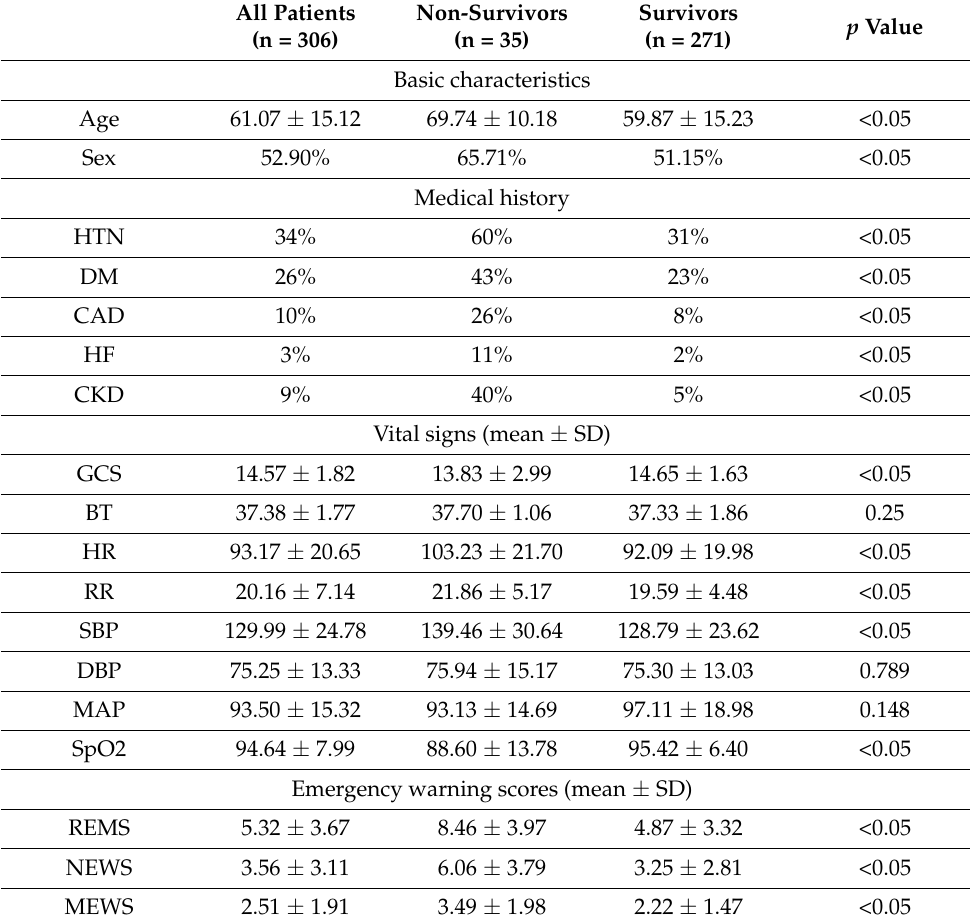
Table 2. Demographic characteristics and initial vital signs at triage of COVID-19 patients in the study cohort.